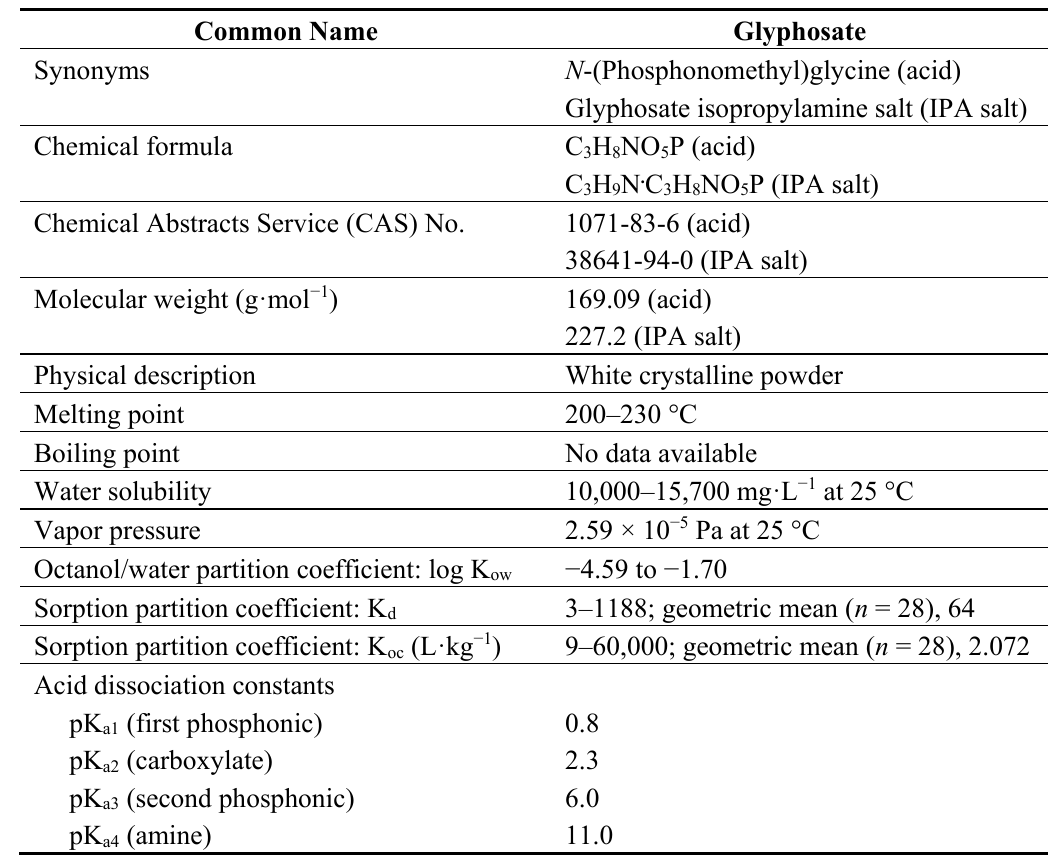
Table 2. Summary of the physical and chemical properties of glyphosate. Modified after Giesy et al.